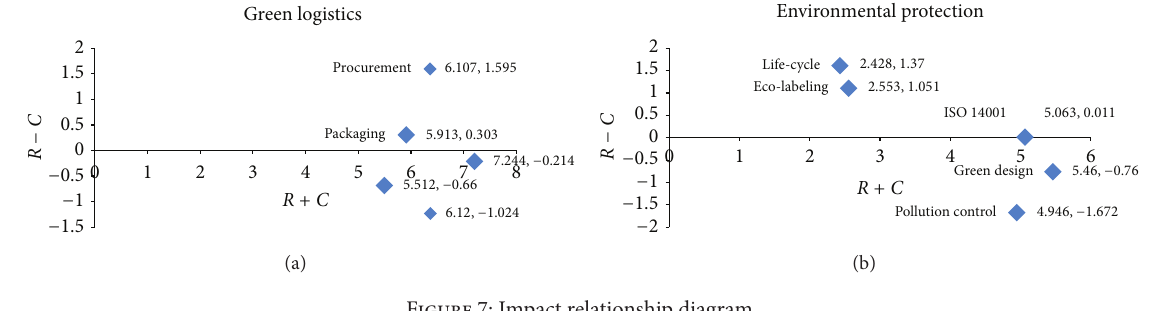
Figure 7: Impact relationship